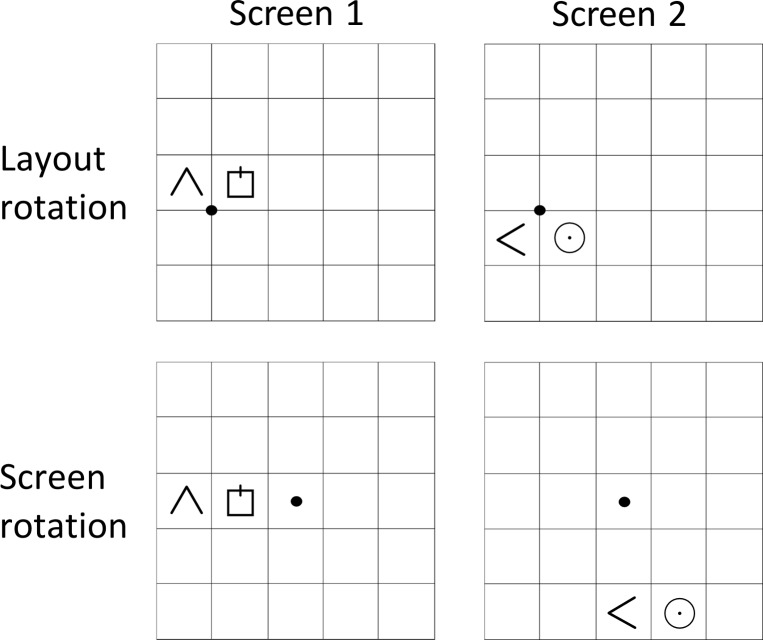
Illustration of layout and screen rotations.Between screens 1 and 2, the presented layout rotated either around the grid cross between the three layout objects or around the center of the screen. Rotation center points are indicated by the black dots, which were not visible during the experiment.